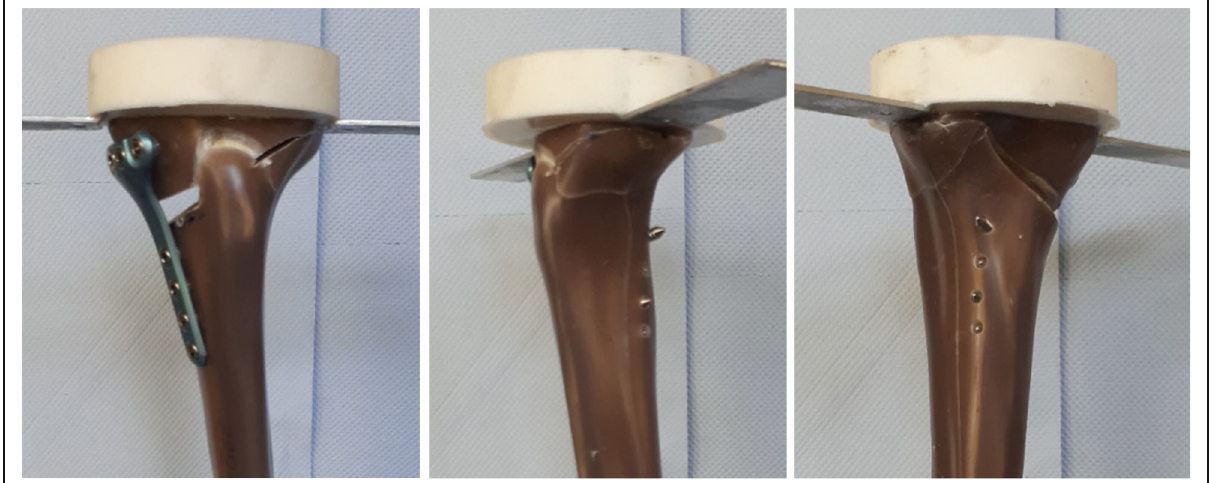
Fig. 5 Fracture of the lateral cortex during cyclical testing (FlexitSystem 4). The opposite cortex appeared to be the weak point of the bone-